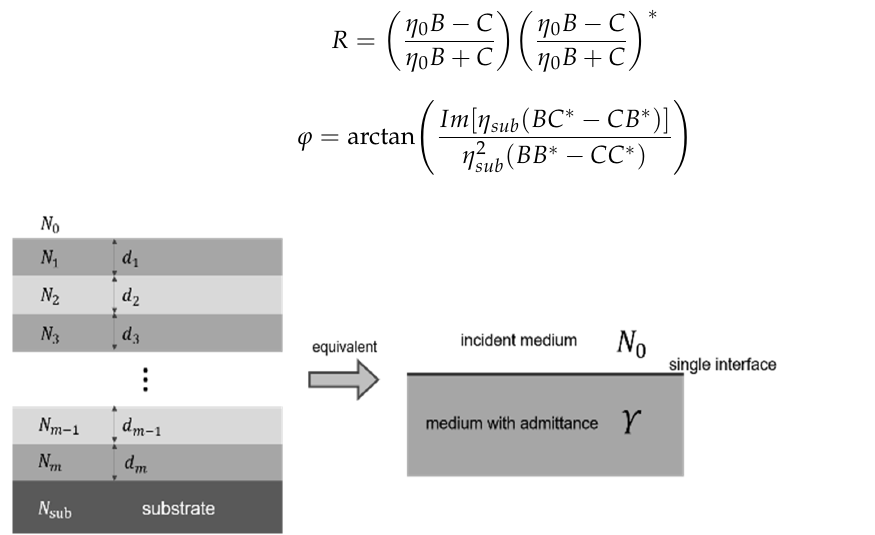
Figure 4. Simplified representation of a thin film multilayer to a single interface.